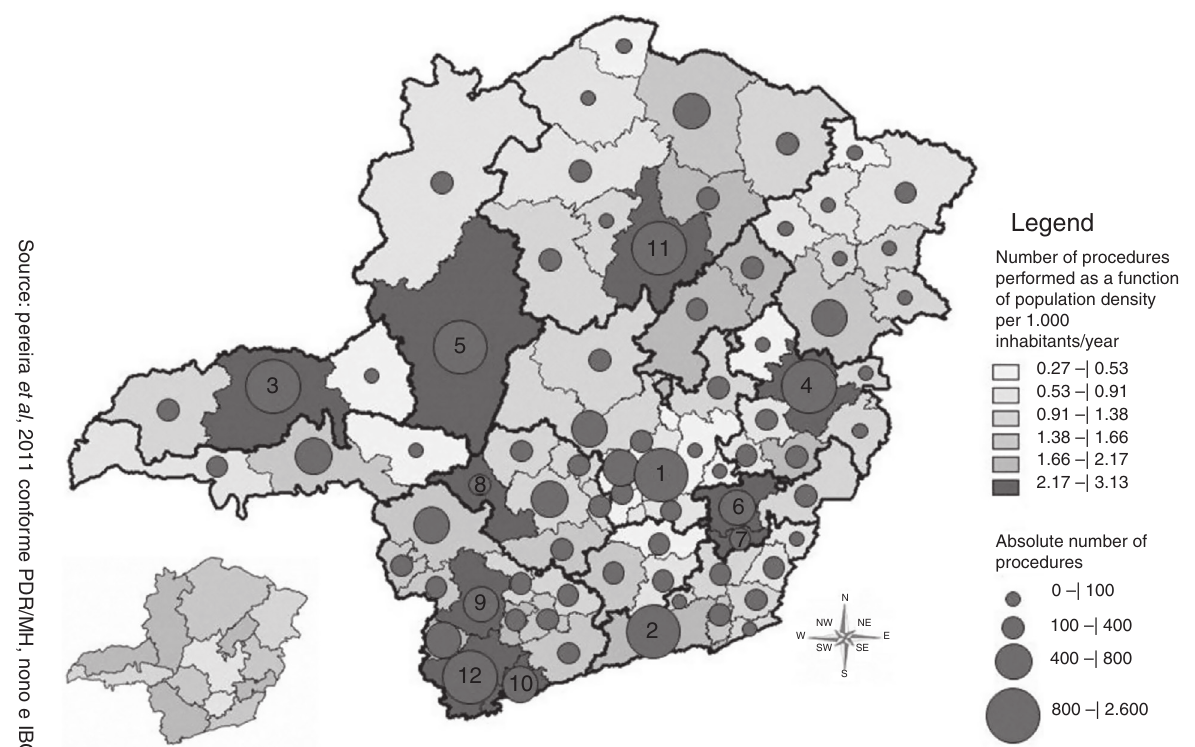
Spatial distribution according to micro- and macro-region of the ‘‘Selection and Adaptation of ISAD’’ procedure per 1000 inhab./year and frequency.